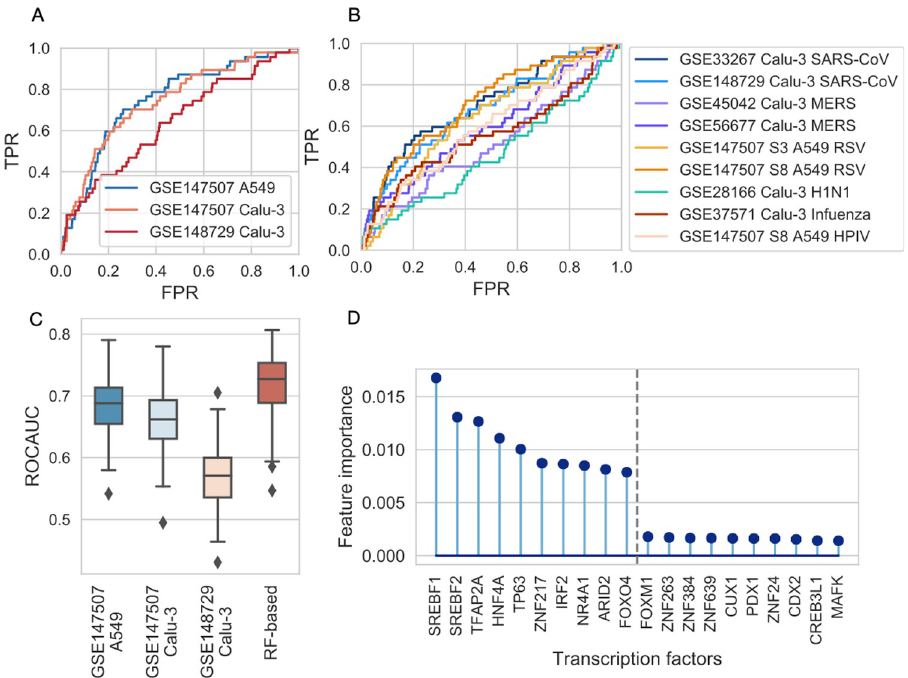
Fig 3. Evaluation of similarity-based and machine learning-based models in predicting in vitro effective drugs. (A, B) ROC analysis of similarity-based predictions of effective drugs against SARS-CoV-2. Drug—SARS-CoV-2 (A) or drug—other virus (B) infection signature similarity was used as prediction score, while known in vitro effective drugs (ChEMBL dataset) were used as true positives. (FPR: false positive rate, TPR: true positive rate) (C) Comparison of predictive performance (ROCAUCs) of similarity-based method (similarity to SARS-CoV-2 infection signature, x- axis) and random forest-based (RF-based, x-axis) prediction. Results of 100 random subsampling cross-validations. In case of similarity-based methods, ROC AUC curves were only calculated for the corresponding cross-validation sets. Boxplots represent the median (central line), first and third quartile (box), minimum and maximum non-outlier values (whiskers) and outliers (diamonds). (D) Feature importances (Gini importance) of the Random Forest model. Top and bottom 10 features (TFs) are shown according to importance.